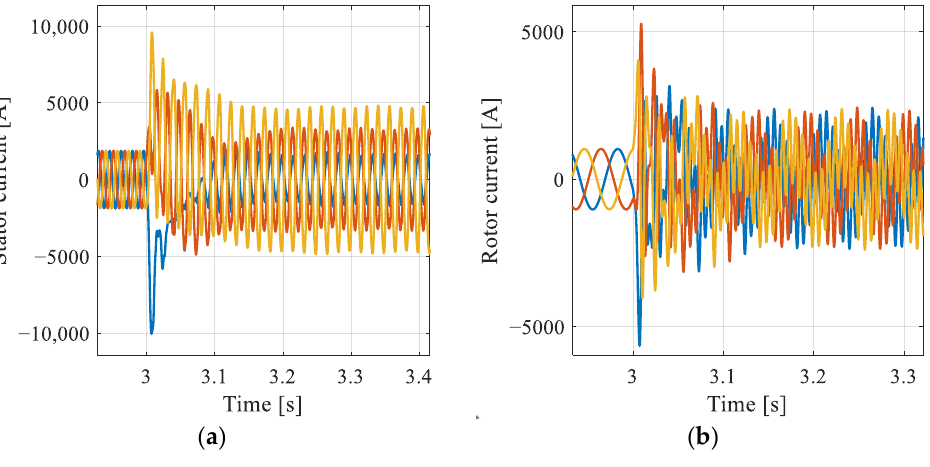
Figure 12. DFIG currents for an unbalanced voltage sag of 20%: ( a ) stator currents and ( b ) rotor currents.